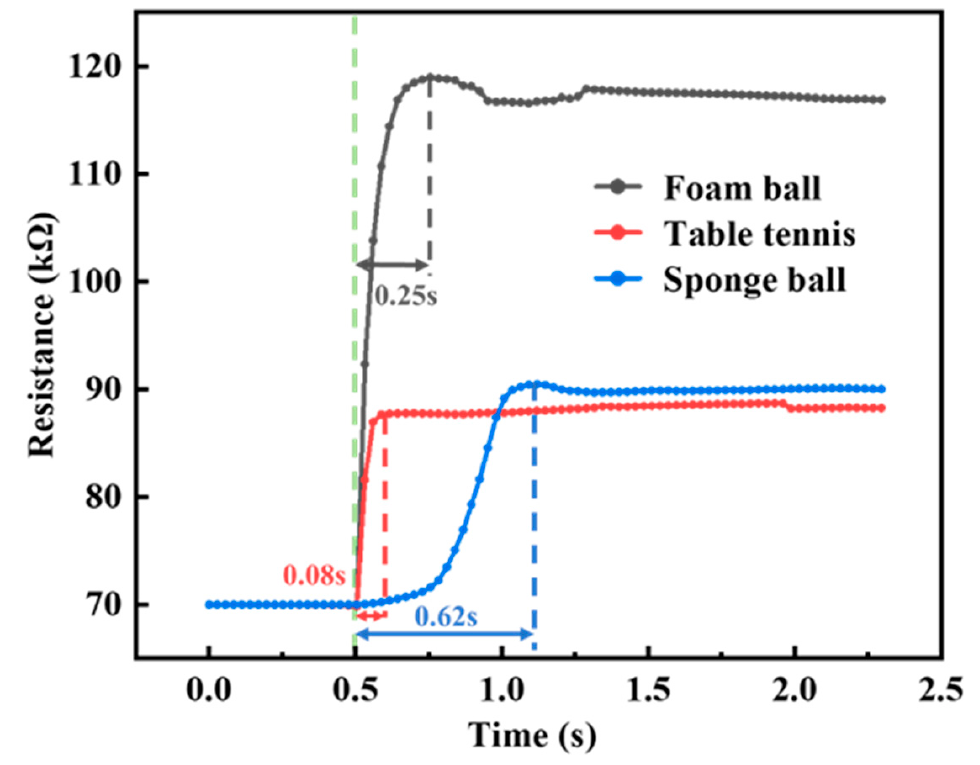
Figure 16. The resistance set value while grasping three kinds of balls.